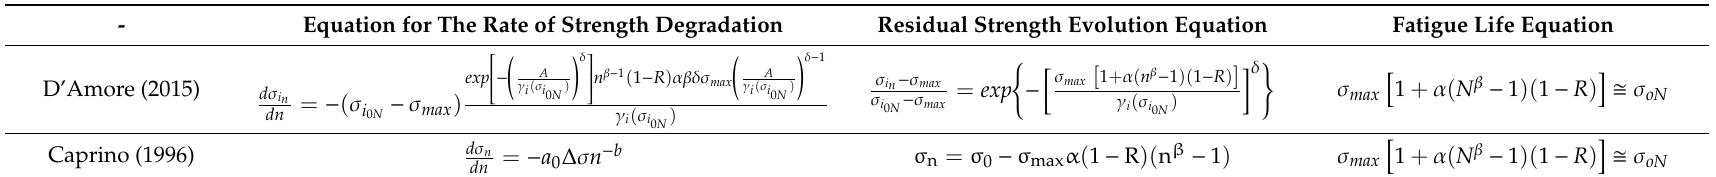
Table 3. Comparison of Caprino’s and D’Amore’s